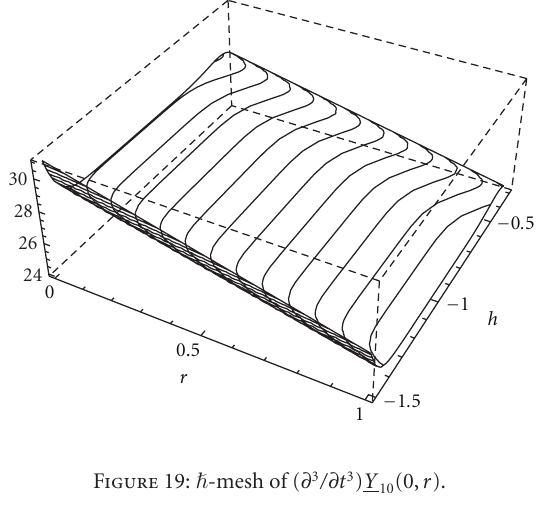
Figure 19: (cid:2) -mesh of ( ∂ 3 /∂t 3 ) Y